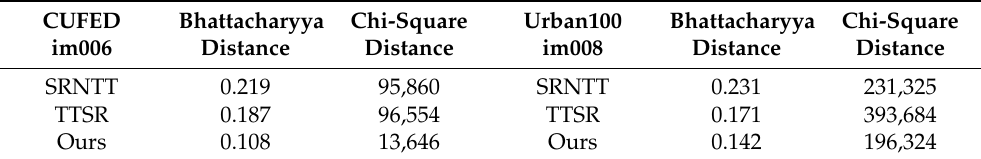
Table 1. Performance comparison: Bhattacharyya distance and Chi-Square